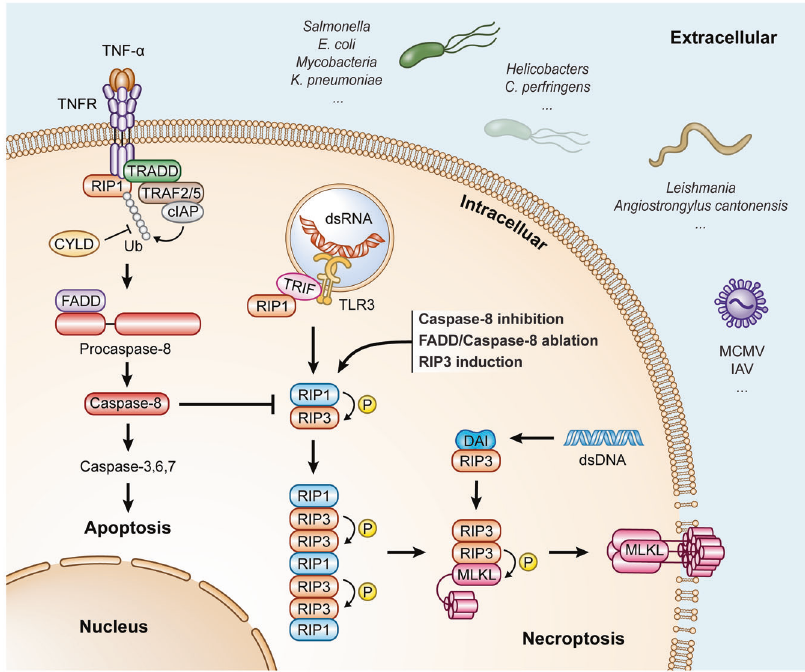
Fig. 2 Regulation of cell apoptosis and necroptosis. Various stimuli, including the TLRs, IFN, death ligands, and pathogenic infections (Viruses, Bacteria, and Parasites), can induce cell death in necroptosis. TNF engages with its receptor and induces cell apoptosis by inhibiting cIAP or deubiquitination of RIP1 by cylindromatosis (CYLD). Instead, inhibition of FADD or caspase-8 can sensitize the cells to undergo necroptosis. Microbial infections can also initiate necroptosis via activation of the receptor-interacting protein kinase 1 (RIP1) and RIP3 complex. Further phosphorylation of MLKL by RIP3 can induce the oligomerization and translocation of MLKL to the membrane, eventually causing cell death. Besides the RIP1-RIP3-MLKL dependent-necroptosis, some RHIM-containing factors like TRIF and IFN-regulatory factors (DAI, also known as ZBP1) mediate the noncanonical necroptosis without the involvement of RIP1. TLRs Toll-like receptors, IFN interferon, FADD Fas-associated protein with death-domain, MLKL mixed lineage kinase do ma in-like, RHIM RIP homology interaction motifs (RHIM), ZBP1 Z-DNA-binding protein